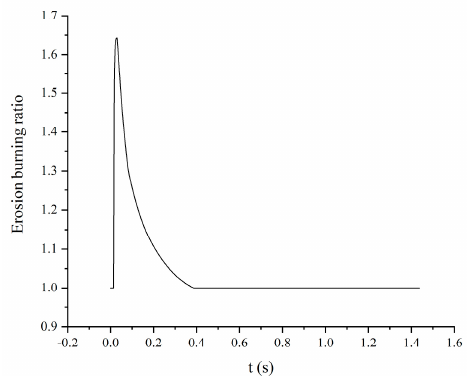
Figure 9. History of erosive burning ratio at the aft end of the Figure 9. Hist ory of erosive burning ratio at the aft end of the grain. Figure 9. Hist ory of erosive burning ratio at the aft end of the grain.